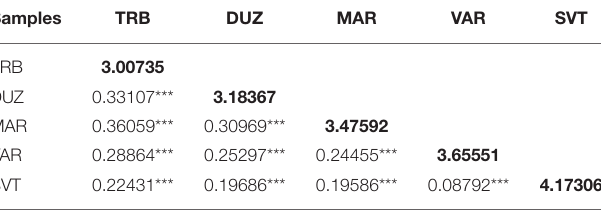
TABLE 3 | Values of microsatellite pairwise F ST (below diagonal) and average number of pairwise differences within population (diagonal elements). Samples